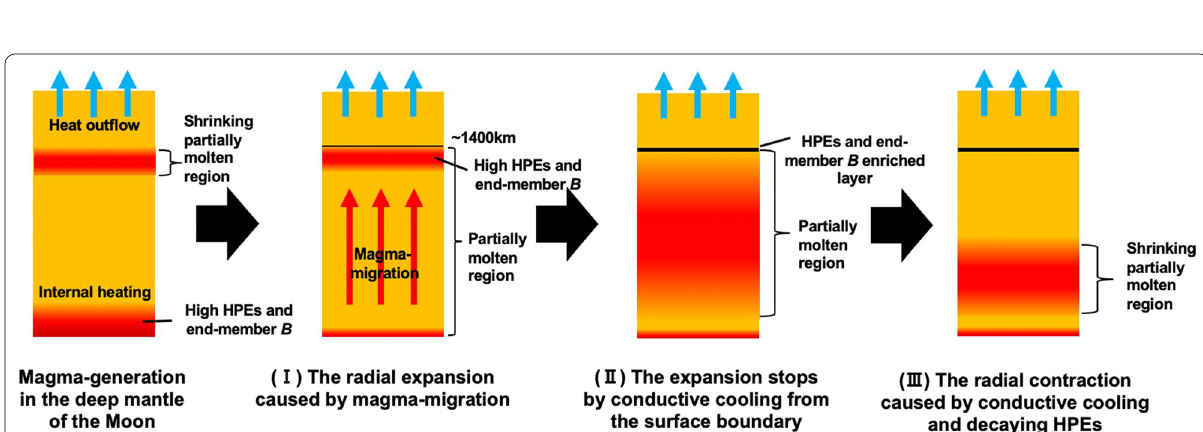
Fig. 7 Illustration of the thermal and structural history of the Moon. For each stage, see Section “The reference